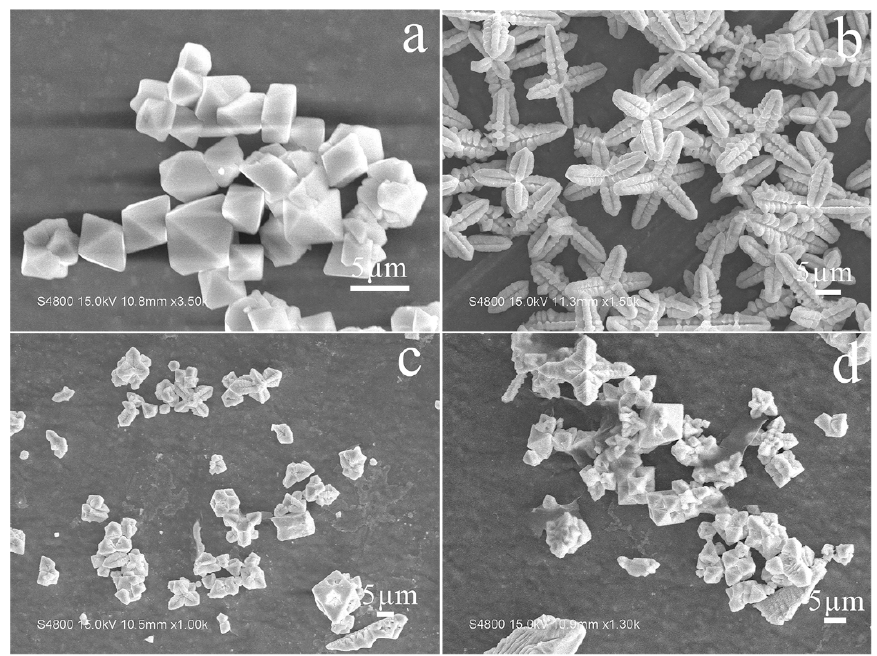
Figure 1. The SEM images of the Cs 2 SnCl 6 crystals prepared with ( a ) 3 mol / L, ( b ) 5 mol / L, ( c ) 9 mol / L, ( d ) 10 mol / L HCl for 0.042 mol / L SnCl 2 solution.